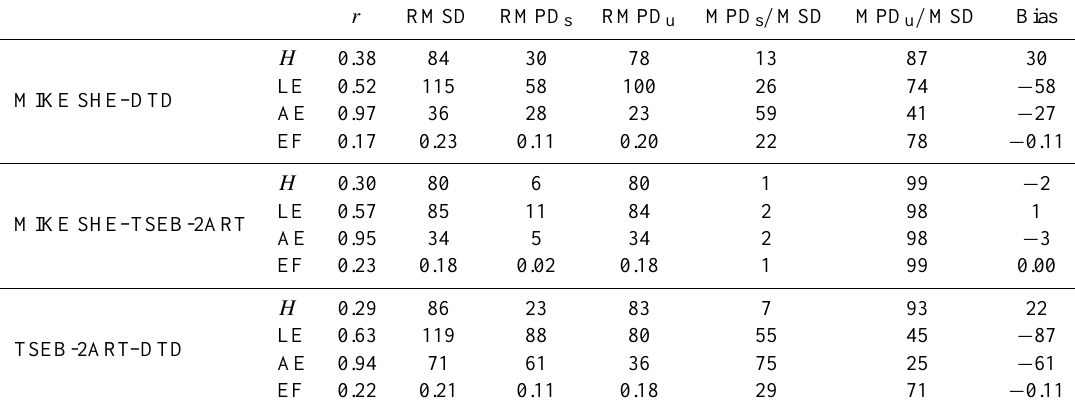
Table 7. Statistical comparison between MIKE SHE, DTD and TSEB-2ART models for sensible and latent heat fluxes ( H and LE), avail- able energy (AE) and evaporative fraction (EF) for model runs with resistance equations taken from Choudhury and Monteith (1988). Statistics used: correlation coefficient ( r ), root mean square difference (RMSD), systematic and unsystematic root mean product differences (RMPD s and RMPD u respectively), the percentage of mean square difference (MSD) attributed to systematic and unsystematic mean prod- uct differences (MPD) (MPD s / MSD and MPD u / MSD respectively) and bias. The statistics for H , LE and AE are in Wm − 2 , with the exception of MPD s / MSD and MPD u / MSD, which are percentages. The statistics for EF are unitless, with the exception of MPD s / MSD and MPD u / MSD, which are